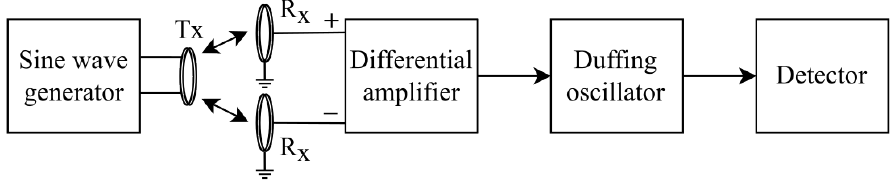
Figure 3. Schematic of the Duffing oscillator-based metal